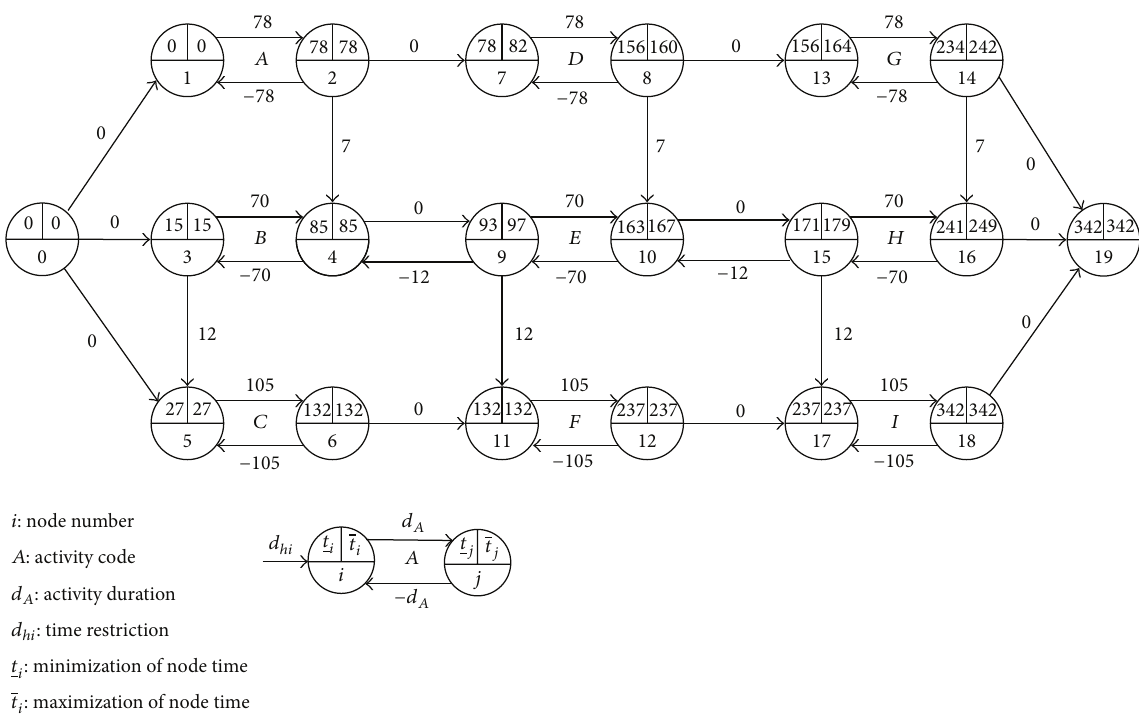
Figure 1: Example of an activity network under GPRs.